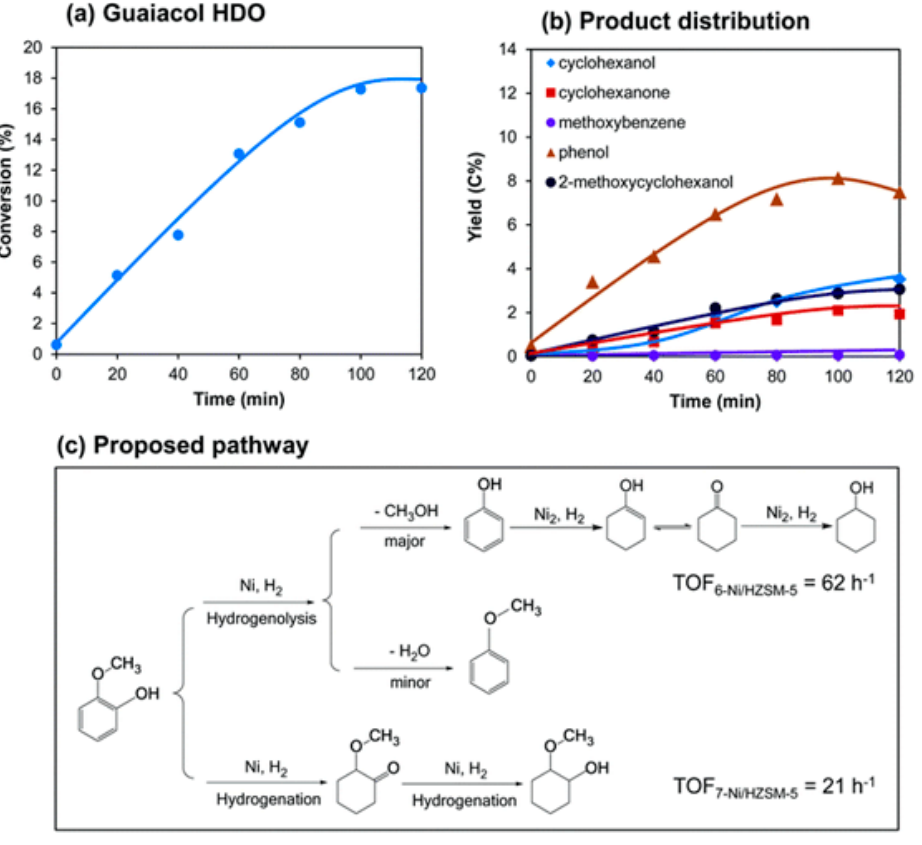
Figure 9. Guaiacol hydrodeoxygenation over Ni / HZSM-5, ( a ) conversion, ( b ) product distribution, ( c ) proposed reaction pathway for ref [44] .